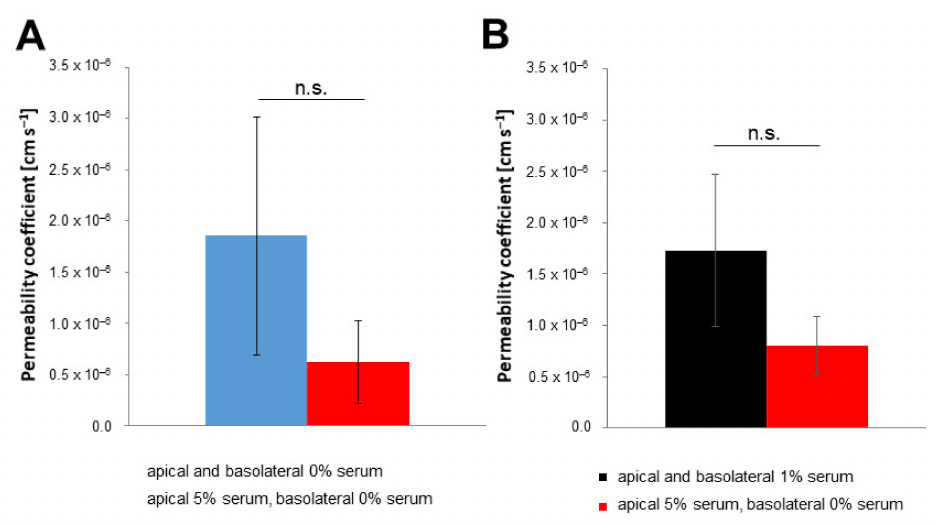
Figure 5. Change in permeability of sodium fluorescein dependent on media serum profiles. Deter- mination of permeability coefficients was performed at the time of maximum TEER value ± 12 h for ( A ) pBCECs and ( B ) hiPS-BCECs. To the apical compartments of the models with standard media (pBCECs—blue; hiPS-BCECs—black) or medium with 5% serum on the apical side and serum-free medium on the basolateral side (both—red), 1 µ M sodium fluorescein was applied. Samples were taken for measurement after 3 h of incubation. Mean ± S.D. was calculated for at least three biological replicates; n.s. p > 0.05.